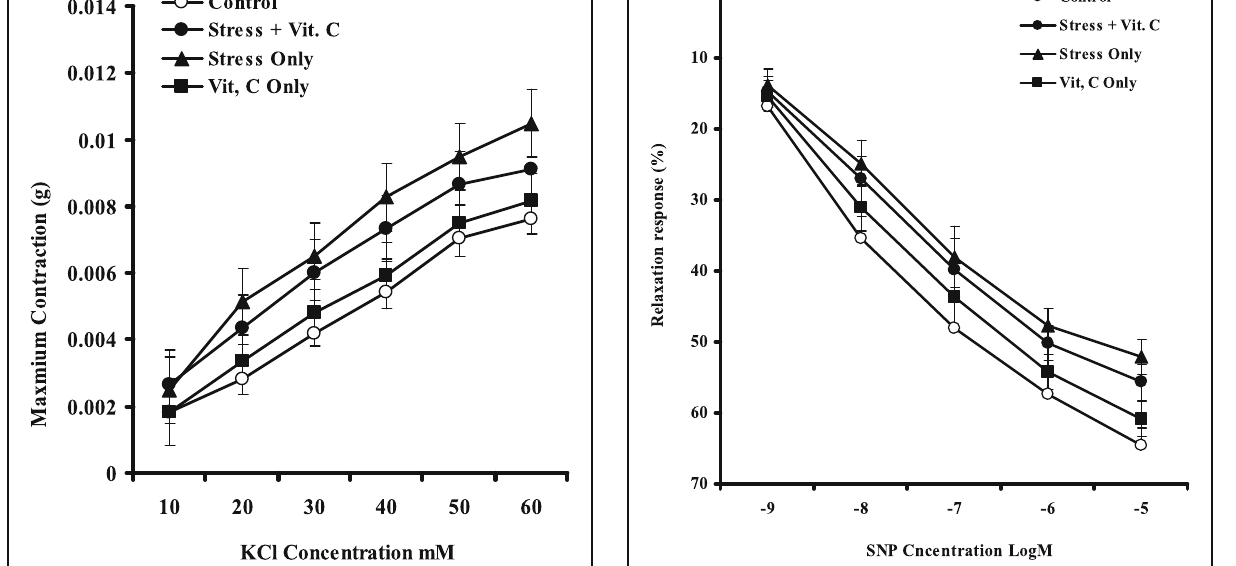
Fig. 3 Graphical representation showing the effect of chronic variable stress with vitamin C supplementation on relaxation responses of testicular artery strip to doses of